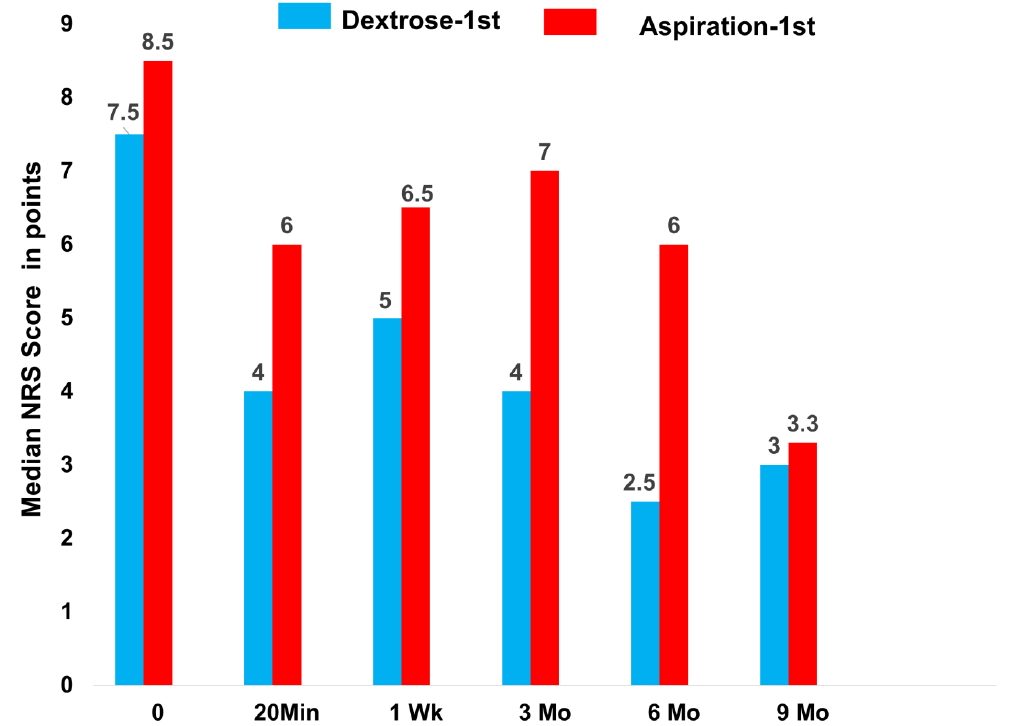
Figure 2. Median NRS pain scores from 0 to 9 months for Dextrose-1st group, given dextrose at time 0 and, then monthly for 6 months, versus Aspiration-1st group, given dextrose at one week and then monthly for 6 months. Table 2. Changes in 0 – 10 NRS scores.